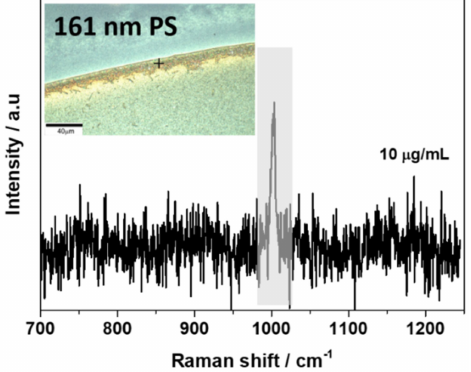
Figure A6. SERS spectra obtained for 10 µ g/mL of 161 nm PS particles on 46 nm AuNP substrates. The spectrum is shown with an image of the region of interest (ROI) the measurement was obtained from. Scale is 40 µ m. Laser power, scan speeds, and number of averaged accumulations for the samples can be viewed in Table